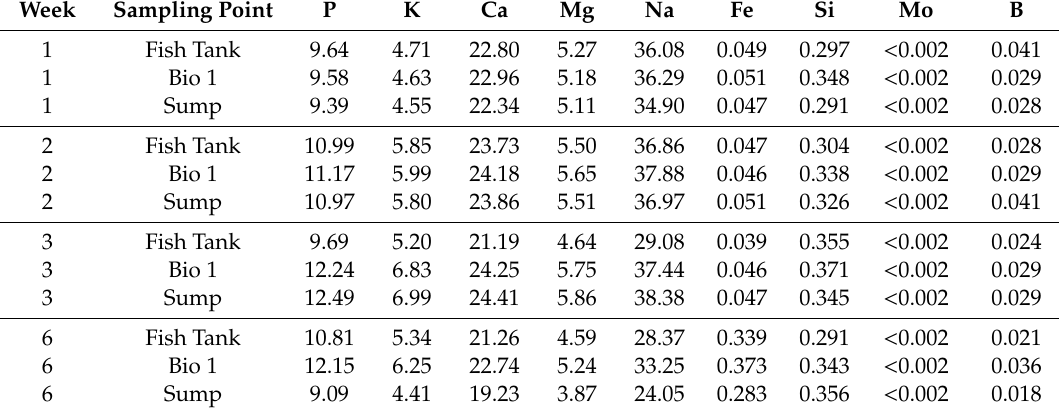
Table 5. Total dissolved macro- and micronutrients (mg / L) in water samples from selected sampling points in System 4 Trial 2 over a 6-week period 1 . All samples were filtered (0.45 µ m, cellulose acetate) immediately after collection.